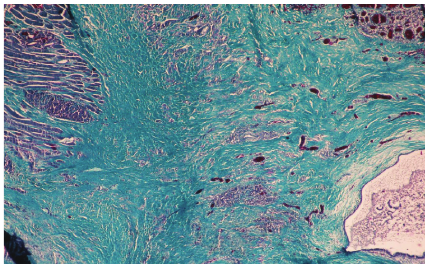
Figure 1: Mallory, 4x. On right side skeletal muscle tissue is visible, and on left side area of endometrial stroma and glands can be